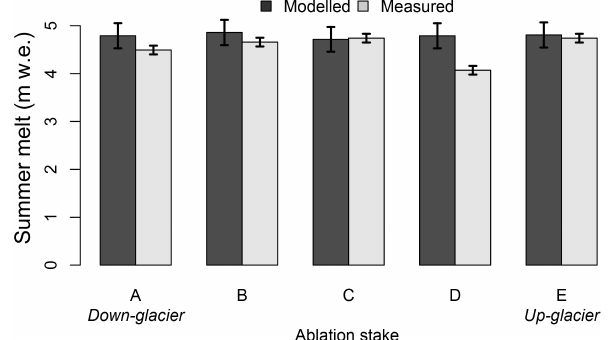
Figure 9. Observed (measured) melt from ablation stakes and mod- elled melt from the DEBM.